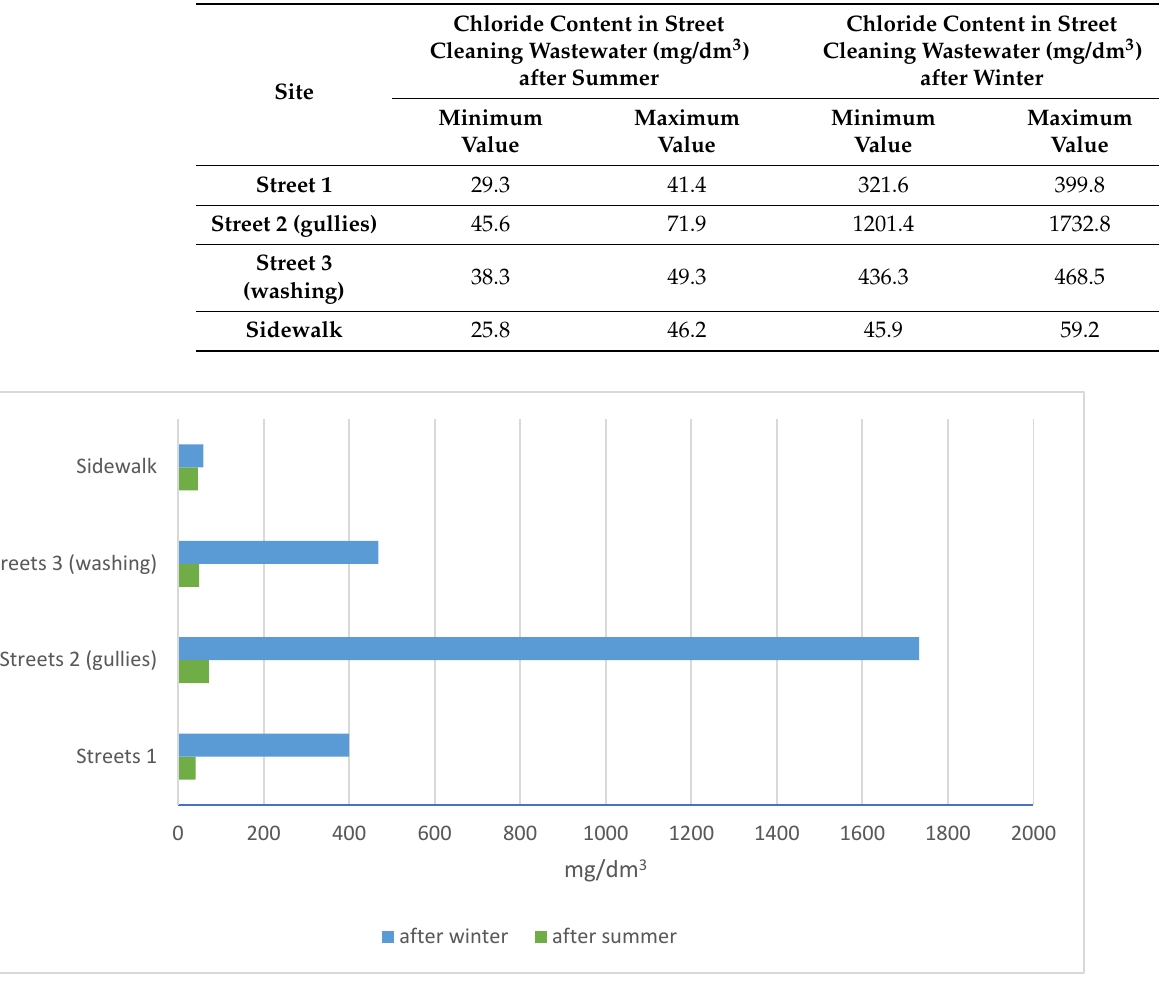
Figure 3. Comparison of chloride content (mg/dm 3 ) on select streets in cleaning sweepings collected after summer and winter (average values).